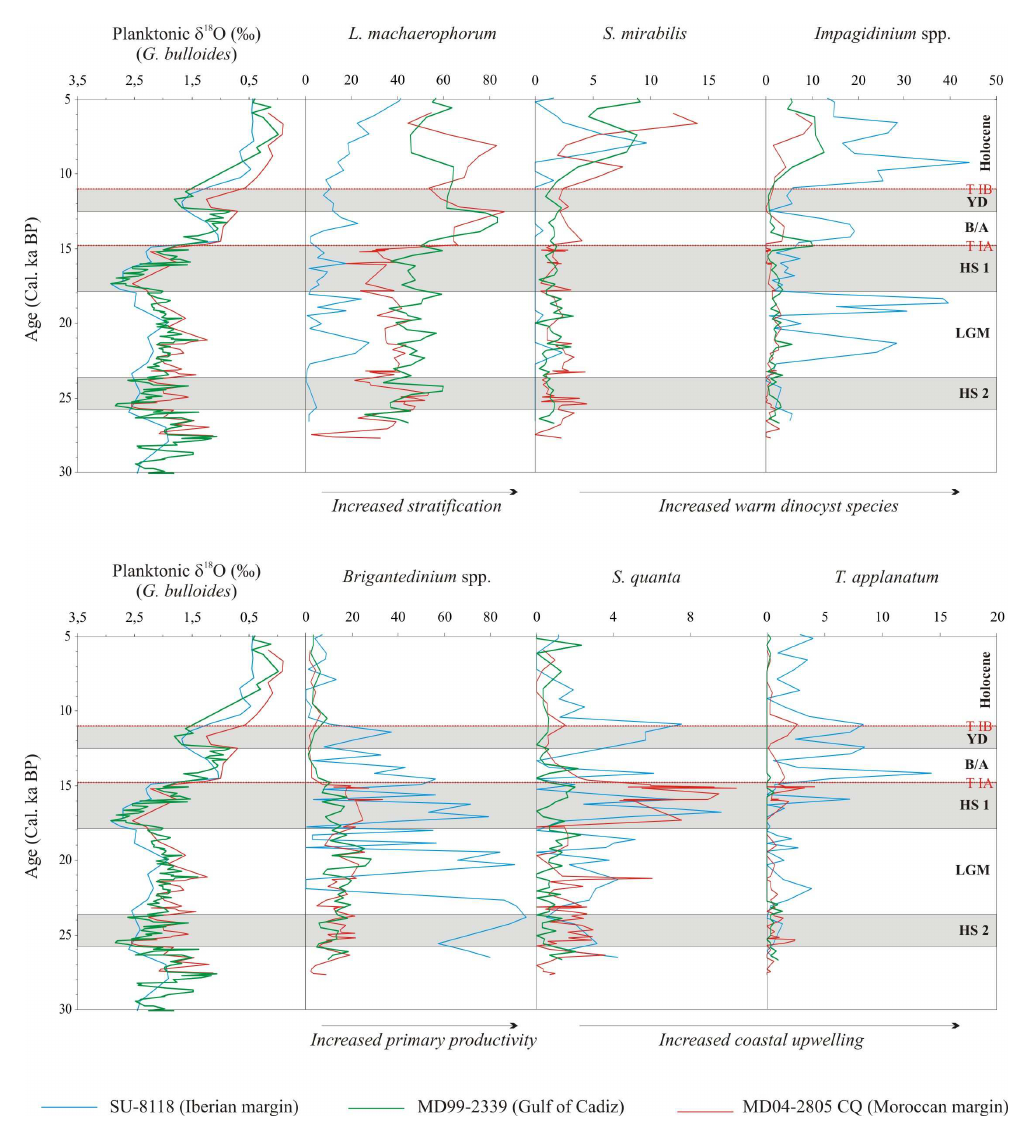
Fig. 7. Comparison of the relative abundances (%) of selected dinocyst species on the three study cores covering the last 30000 years. The color code is mentioned for each core. The planktonic δ 18 O records provide the stratigraphic framework for the three sedimentary